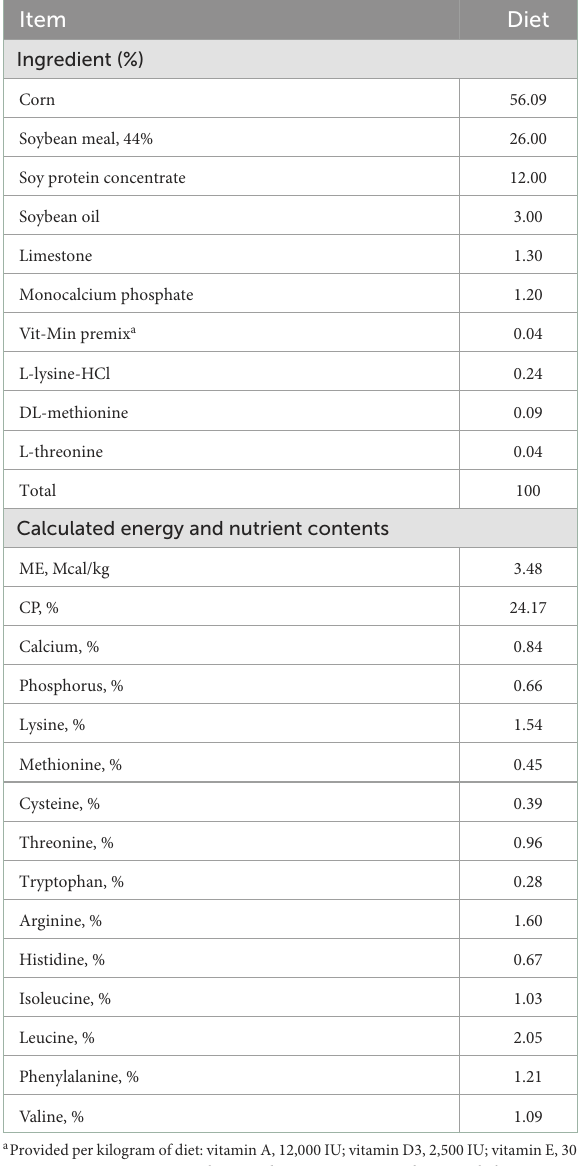
TABLE 1 Composition of basal diet for weaned pigs (as-fed